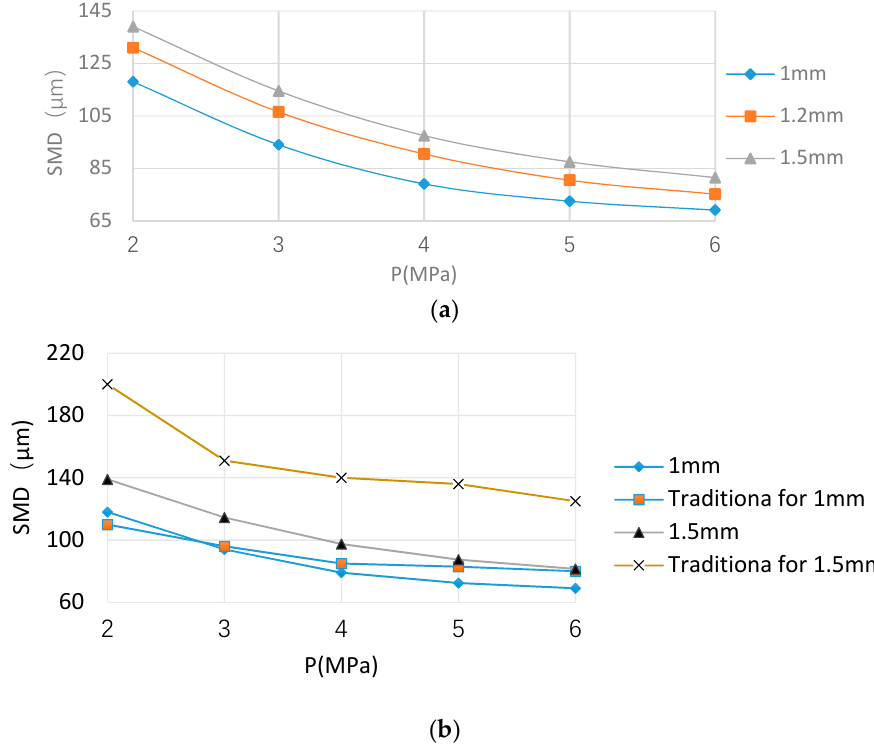
Figure 6. Size of droplets (Sauter Mean Diameter, SMD) in different spray pressures (P) and nozzle diameters. ( a ) SMD and spray pressures for three nozzle apertures. ( b ) The comparison between the nozzle and the traditional nozzles in the SMD.